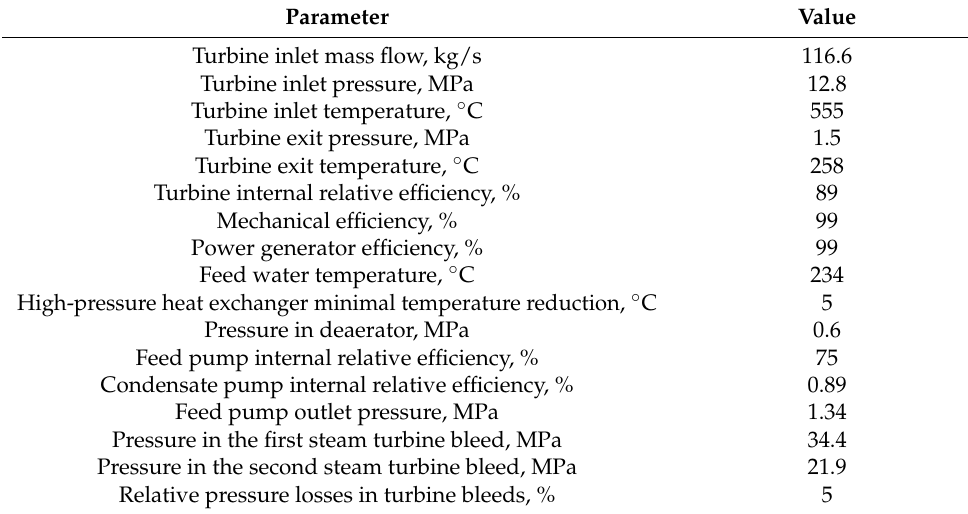
Table 2. Main characteristics and parameters of the